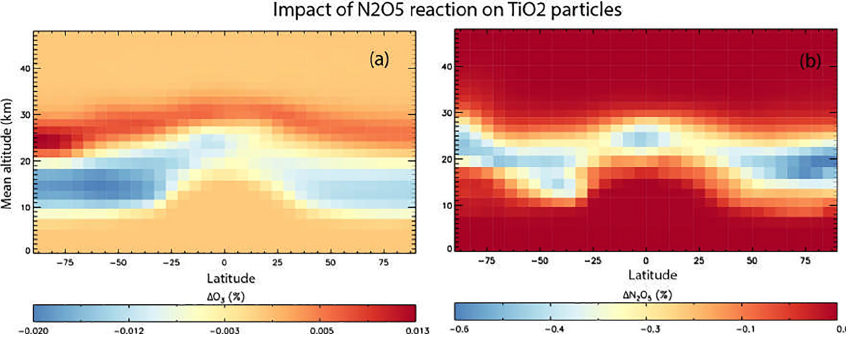
Figure 8. Annual mean change (%) in atmospheric O 3 (a) and N 2 O 5 (b) calculated using the TOMCAT 3-D model from inclusion of heterogeneous loss of N 2 O 5 on TiO 2 particles for 2008 and using γ (N 2 O 5 ) =